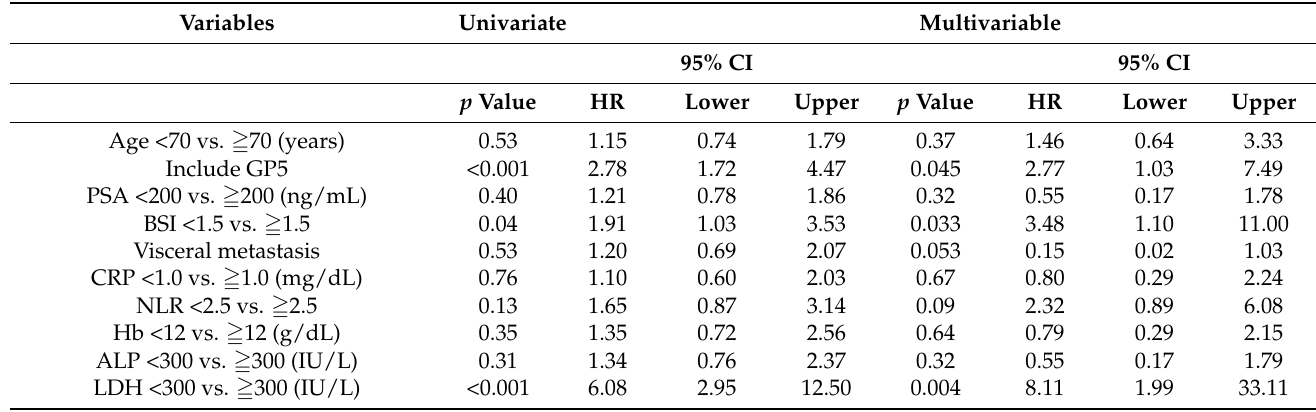
Table 2. Univariate and multivariable analysis of prognostic factors for overall survival.